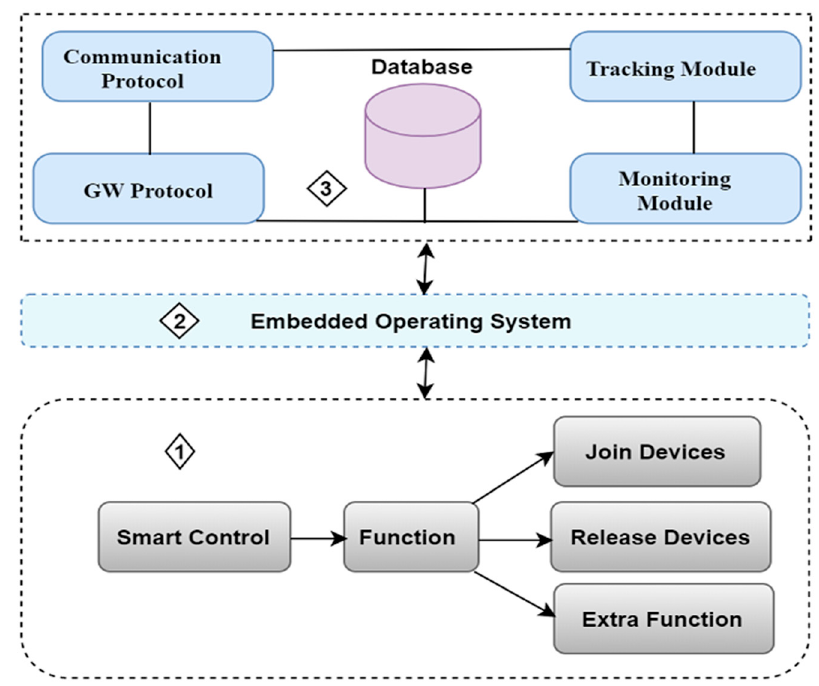
Figure 3. Architectural view of the IoT-SDN smart gateway .